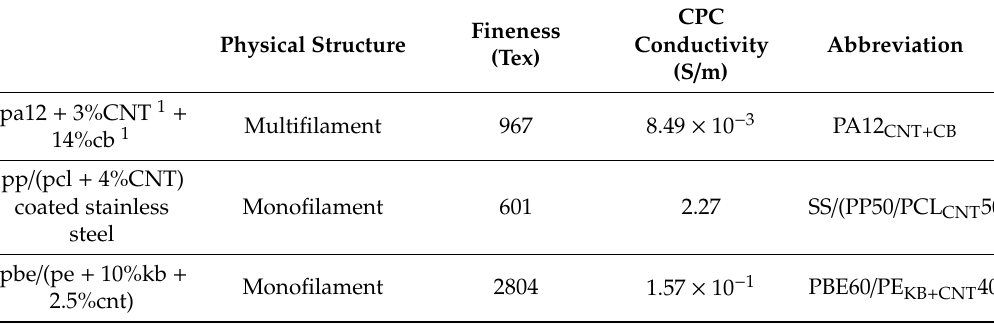
Table 3. Summary of the di ff erent conductive polymer composite (CPC)